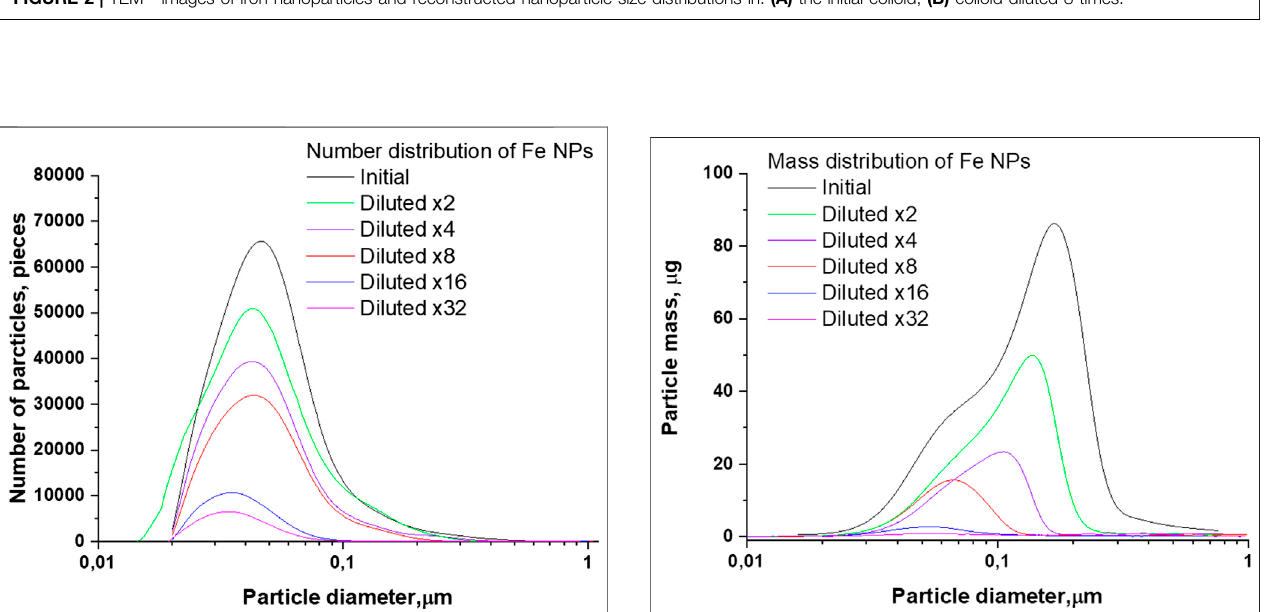
FIGURE 2 | TEM - images of iron nanoparticles and reconstructed nanoparticle size distributions in: (A) the initial colloid; (B) colloid diluted 8 times.